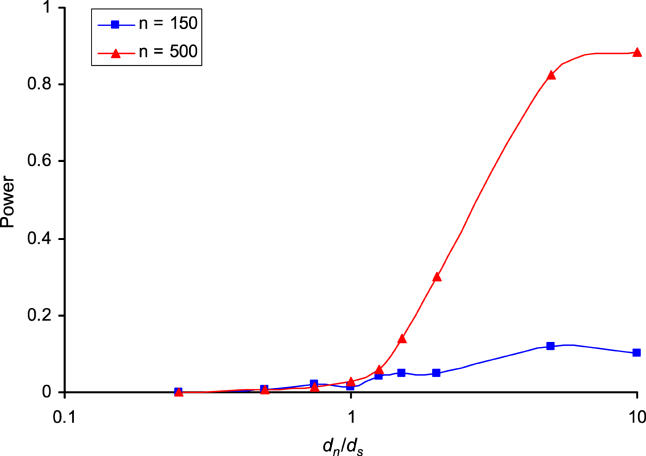
Power of the Likelihood Ratio Test for Positive SelectionThe power is shown as a function of the proportion of the dN/dS ratio, and for sequence lengths (n) of 150 and 500 codons. Power is defined as the proportion of tests that are significant at the 5% level. Simulation parameters, including codon frequencies, transition/transversion bias, and divergence times, are equal to the values estimated from the data. Notice the logarithmic x-axis.